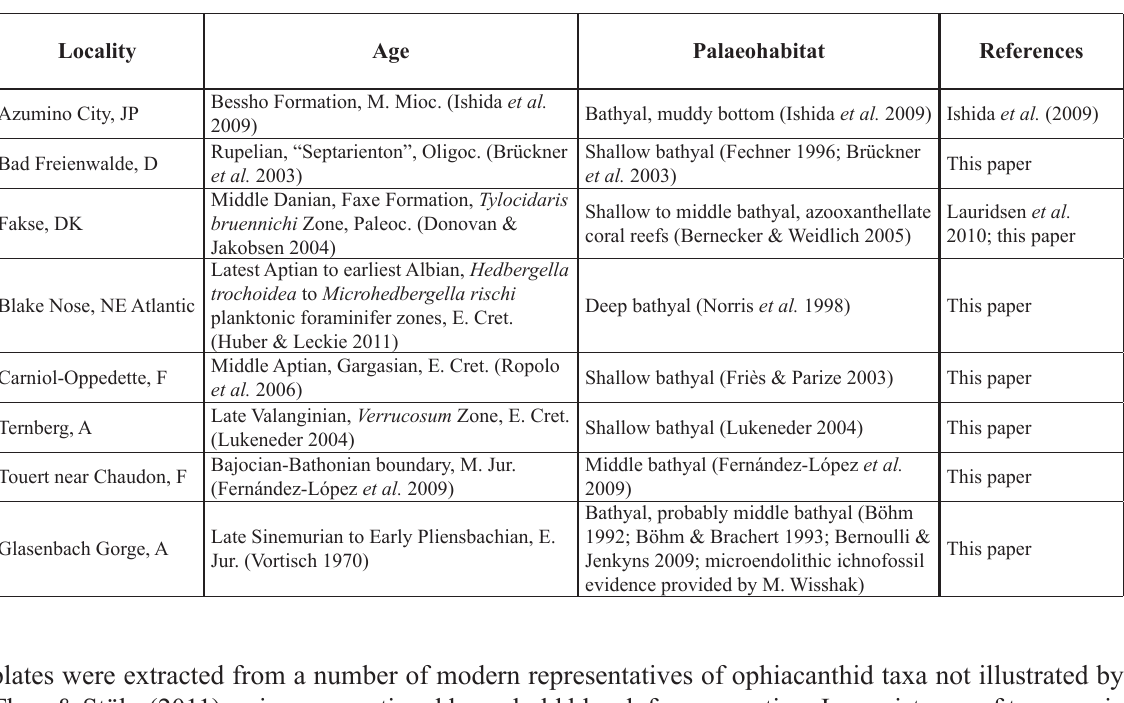
Table 2. Locality details of previously published and new deep-sea ophiuroid assemblages (as studied herein), including reference-supported details on the age and, whenever available, the stratigraphic unit, as well as palaeodepth classification (see section Material and methods) and substrate interpretation. References for previously published ophiuroid assemblages are given. Country acronyms: A =